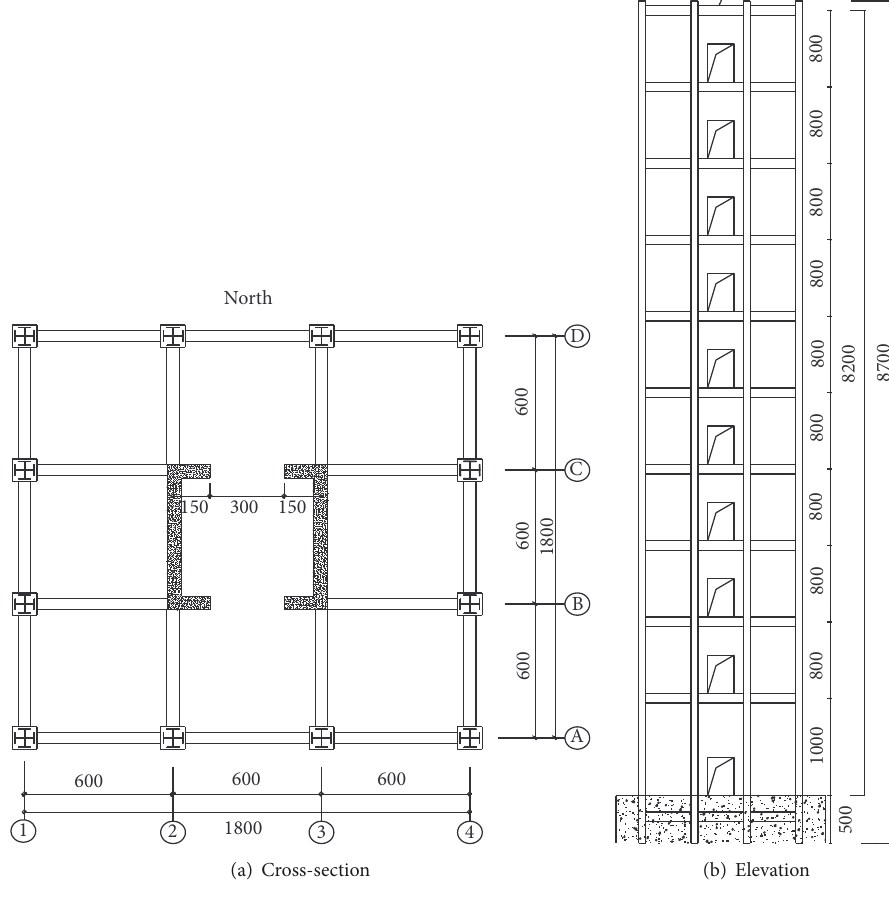
Figure 1: Dimensions of specimen (units: mm).